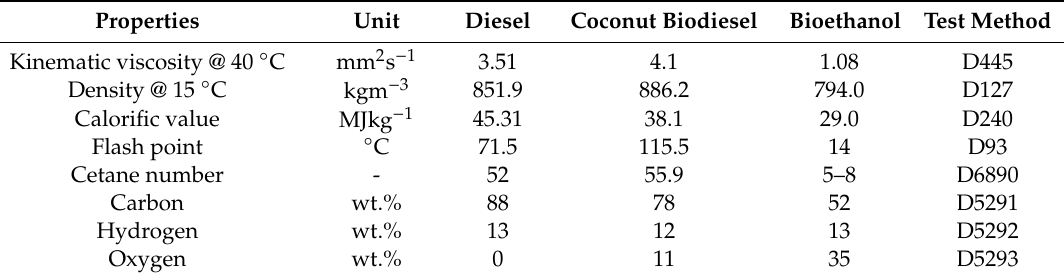
Table 1. Main properties of blending feedstock.